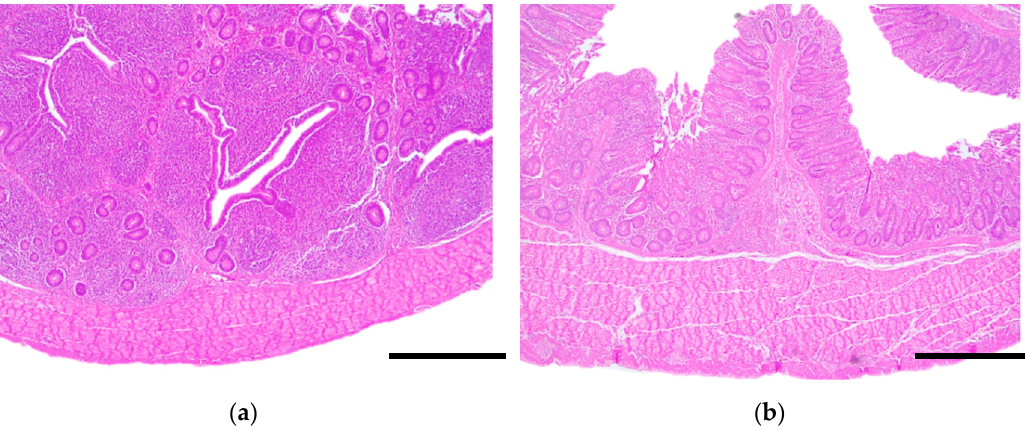
Figure 4. Histopathological study of the cecum of 14-day-old broilers, 7 days post-infection with Salmonella Typhimurium. ( a ) Control group. There is a severe lymphocytic inflammatory infiltrate that completely distorted the crypt structure. GALT hyperplasia is evident. ( b ) Treated group. The lamina propria is mildly expanded by a lymphocytic inflammatory infiltrate. 20×, scale bar: 250 μ m.